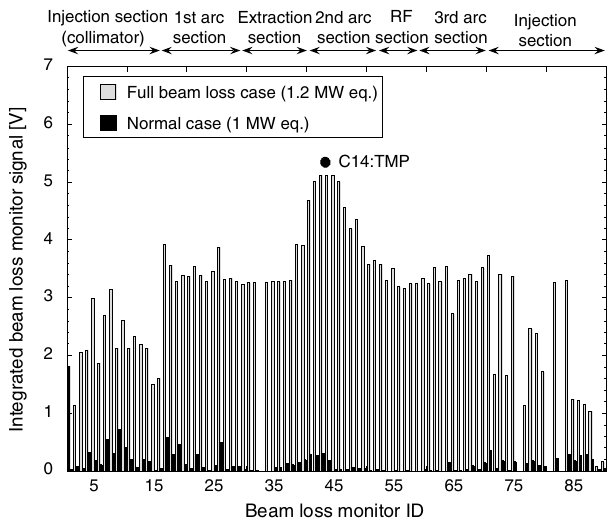
FIG. 10. Damaged bearing parts of the TMP. (a) Inner bearing rail with impressions by the balls. (b) Bearing ball with